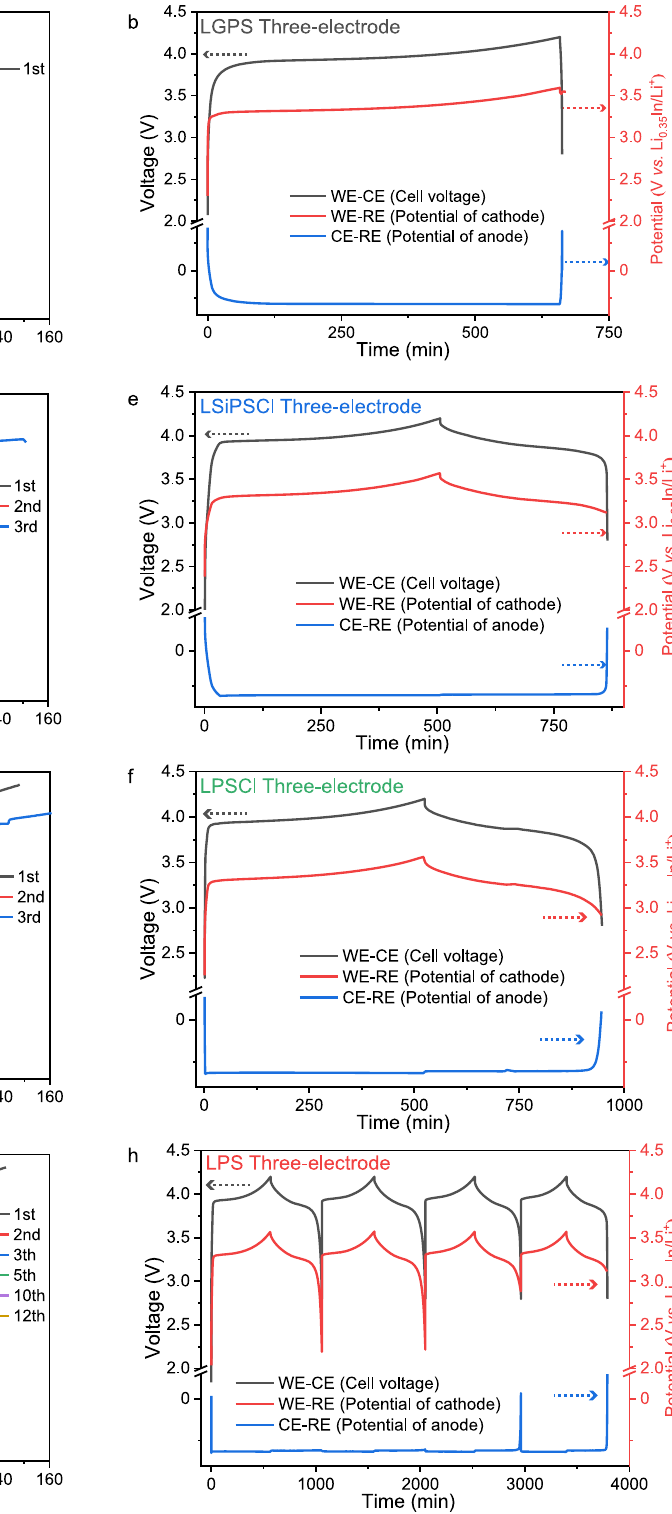
Fig.1|ElectrochemicalperformanceofAFBswithfourdifferentSSEs.a Charge/ discharge curves of AFBs with LGPS. b Voltage/potential vs. time of the three electrode AFBs with LGPS. c , d Charge/discharge curves of AFBs with LSiPSCl ( c ) and LPSCl ( d ). e , f Voltage/potential vs. time of the three electrode AFBs with LSiPSCl( fi rstcycle)( e )andLPSCl( fi rstcycle)( f ). g Charge/dischargecurvesofAFBs with LPS. h Voltage/potential vs. time of the three electrode AFBs with LPS (initial